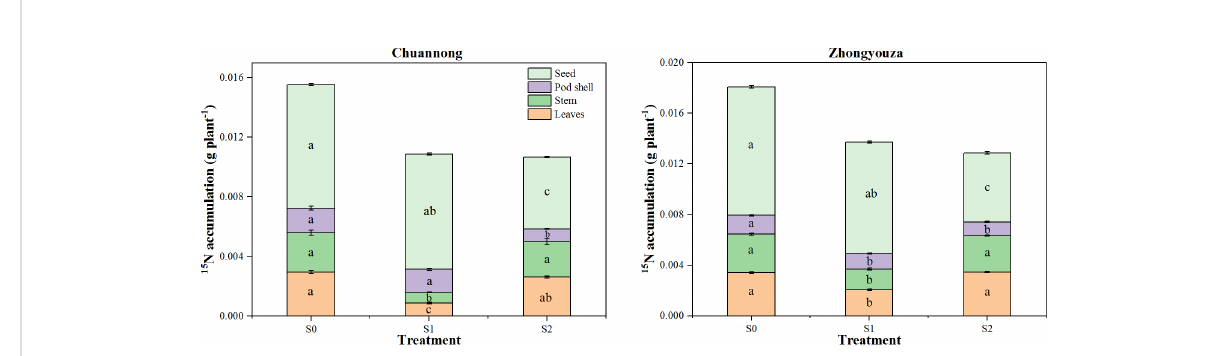
FIGURE 5 Distribution of 15 N to different plant organs of rapeseed at maturity under different shade conditions. S0= control (ambient light); S1= shade at the whole fl owering stage and S2= shade at the start of pod development to pod maturity. Values were determined using the (n=3) LSD test, and various small letters denote the signi fi cance level of treatments at the 0.05 probability level (Duncan